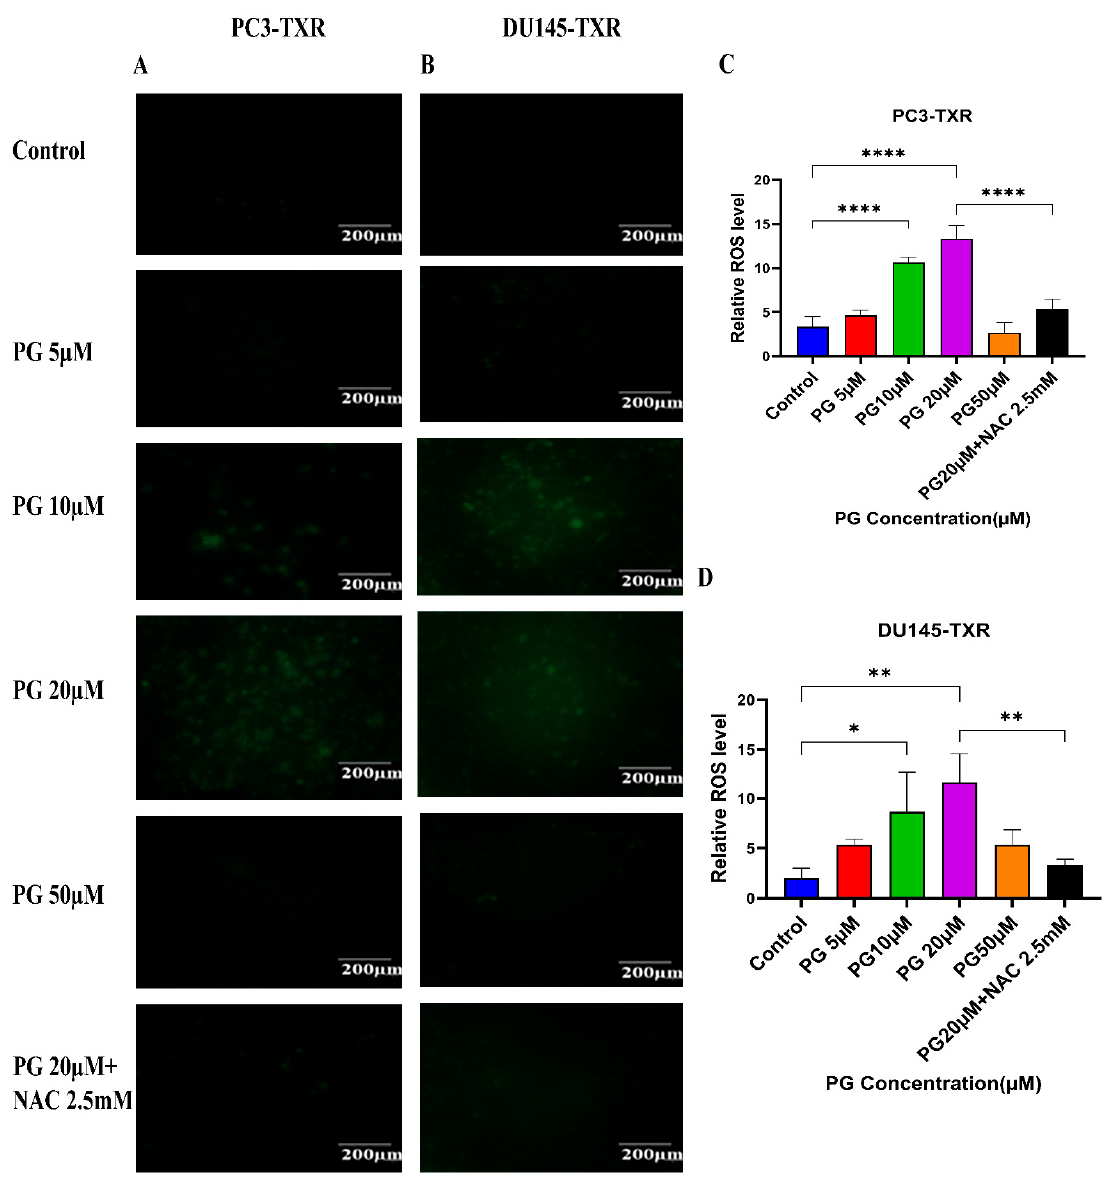
Figure 10. PG treatment induces ROS generation, leading to oxidative stress in taxane-resistant PCa cell lines. The taxane-resistant PCa cell lines were treated with varying concentrations of PG for 6 h and stained with DCFH2-DA. The images were taken and analyzed using ImageJ software. ( A ) PC3-TXR and ( B ) DU145-TXR show an increase in green fluorescence with an increase in PG treatment up to PG 20 µM compared to the control, but PG 50 µM shows slight green fluorescence. ( C ) and ( D ) represent the quantified results of relative ROS levels plotted against concentrations of PG of PC3-TXR and DU145-TXR. Images were taken at 40X magnification. Data are represented as mean ± SD ( n = 3), and three experiments were carried out in triplicate. * p < 0.05, ** p < 0.01, **** p < 0.001.